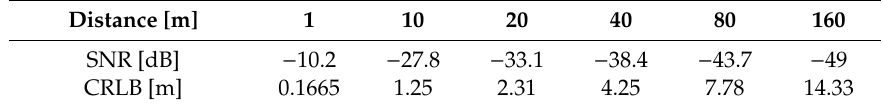
Table 4. CRLB for timestamp estimation by STS in noisy channels and multipath